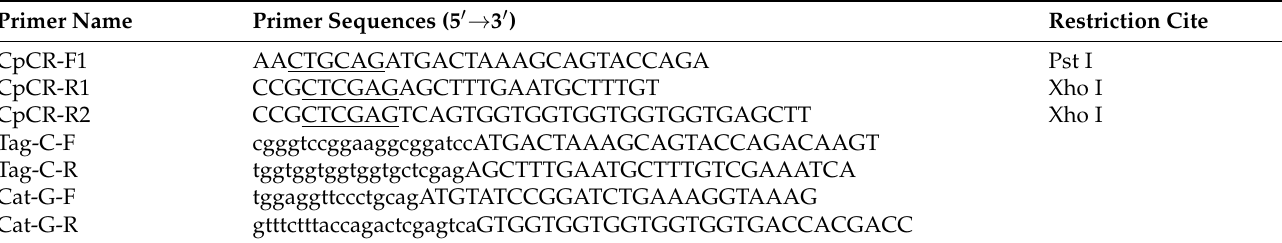
Table 2. Primers used in this study.